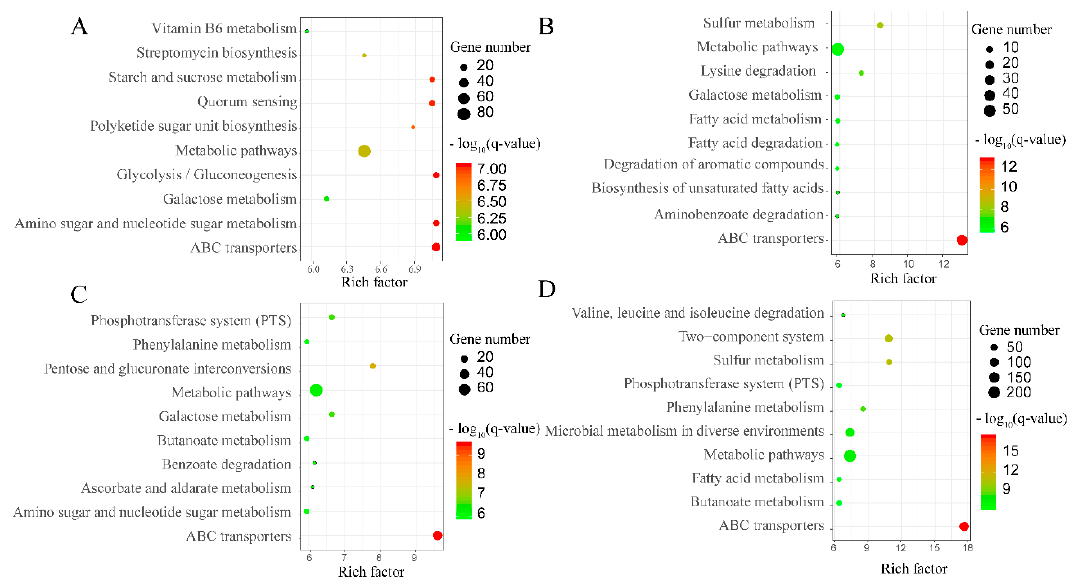
Figure 4. KEGG pathway enrichment scatter plot of specific genes for different Geobacillus species. The x -axis represents the rich factor, and the y -axis shows the name of the KEGG pathway. Dot size represents the number of associated genes, and the color indicates the − log 10 (q-value). ( A – D ) Representations of the enrichment analysis of G. stearothermophilus , G. thermocatenulatus , G. thermodenitrificans , and P. thermoglucosidasius , respectively.